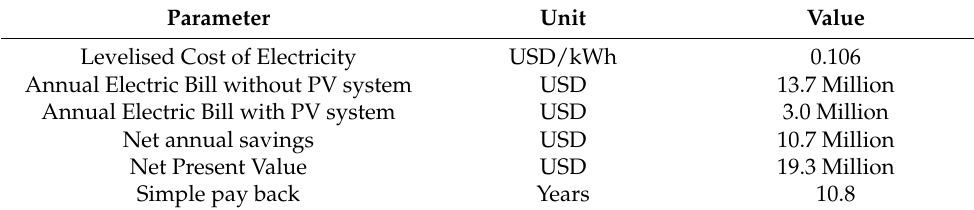
Table 16. Economic performance indicators for the PV and battery